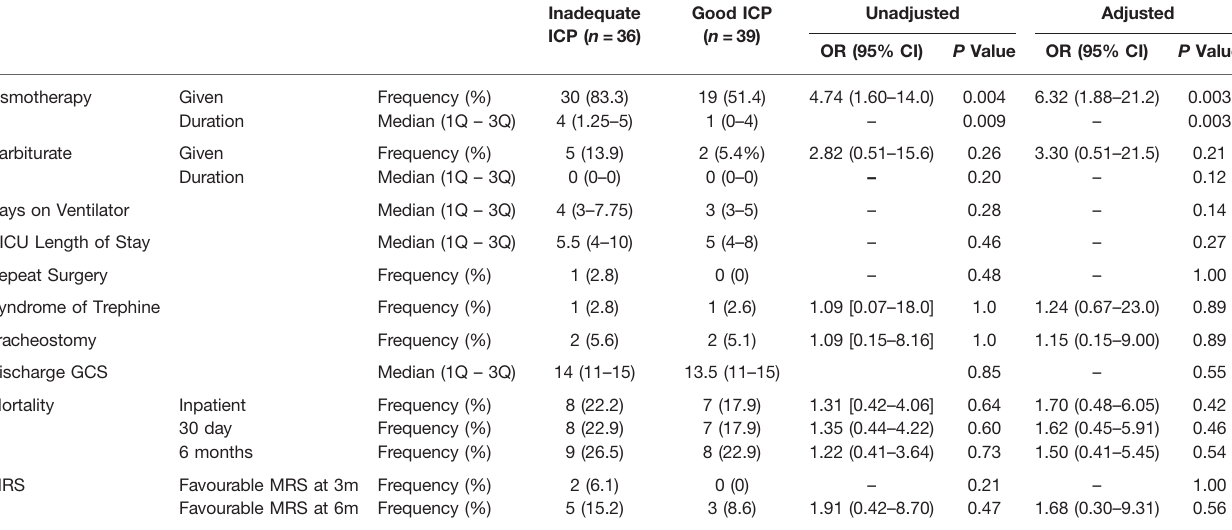
TABLE 2 | Outcomes using ICP threshold of 7